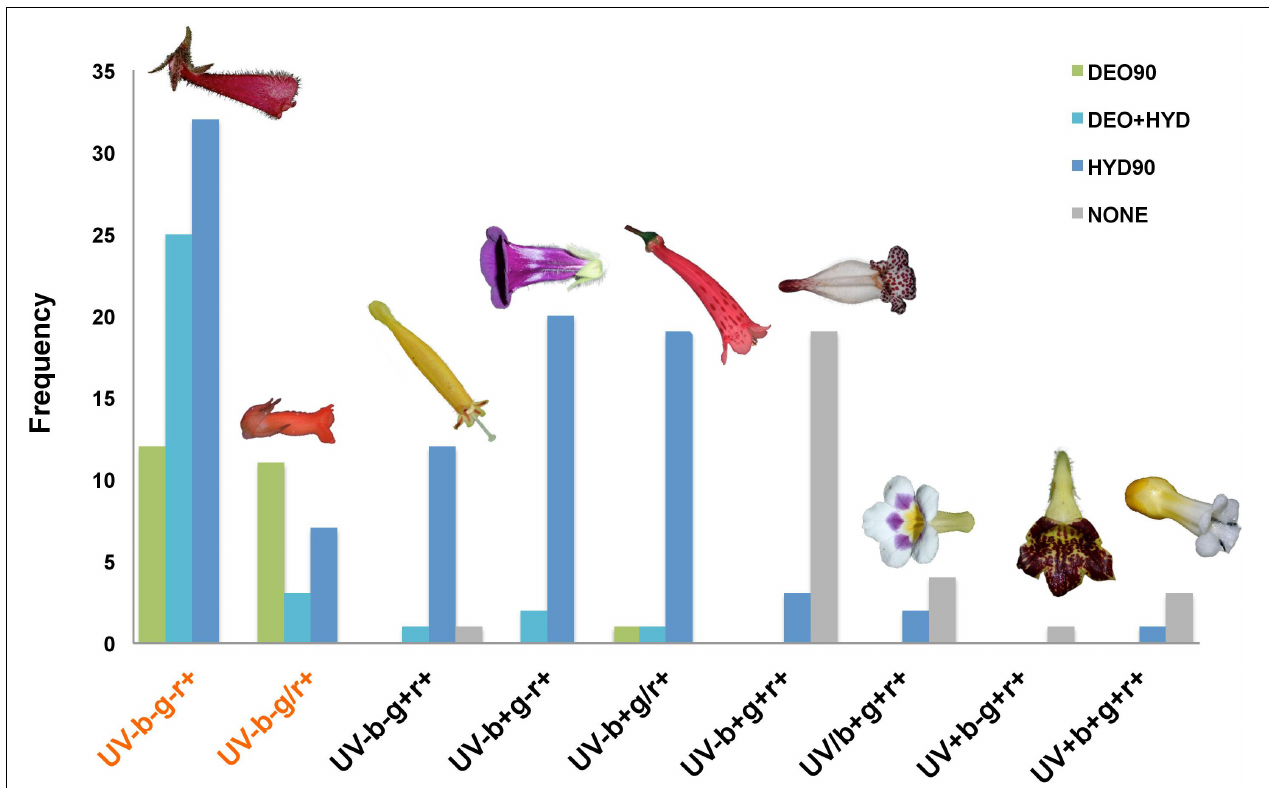
FIGURE 4 | Color groups in the Gesnerioideae flowers. UV: UV (300–400 nm), b: blue (400–500 nm), g: green (500–600 nm), r: red (600–700 nm). –, /, + symbols represent no reflectance, partial reflectance, and full reflectance in the specified region of the spectrum. Color groups representing orange/red hues are shown in red text. DEO90 (green): samples with > 90% DEO; DEO+HYD (cyan): samples with both DEO and HYD between 10 and 90%; HYD90 (blue): samples with > 90% HYD; NONE: no-anthocyanin samples. Flowers representing each color group are shown at the top of each category. From left to right: Nematanthus monanthos, Sinningia allagophylla, Columnea purpureamarginata, S. bragae, S. douglasii, N. punctatus, Diastema sp., Gasteranthus leopardus, and Besleria selloana